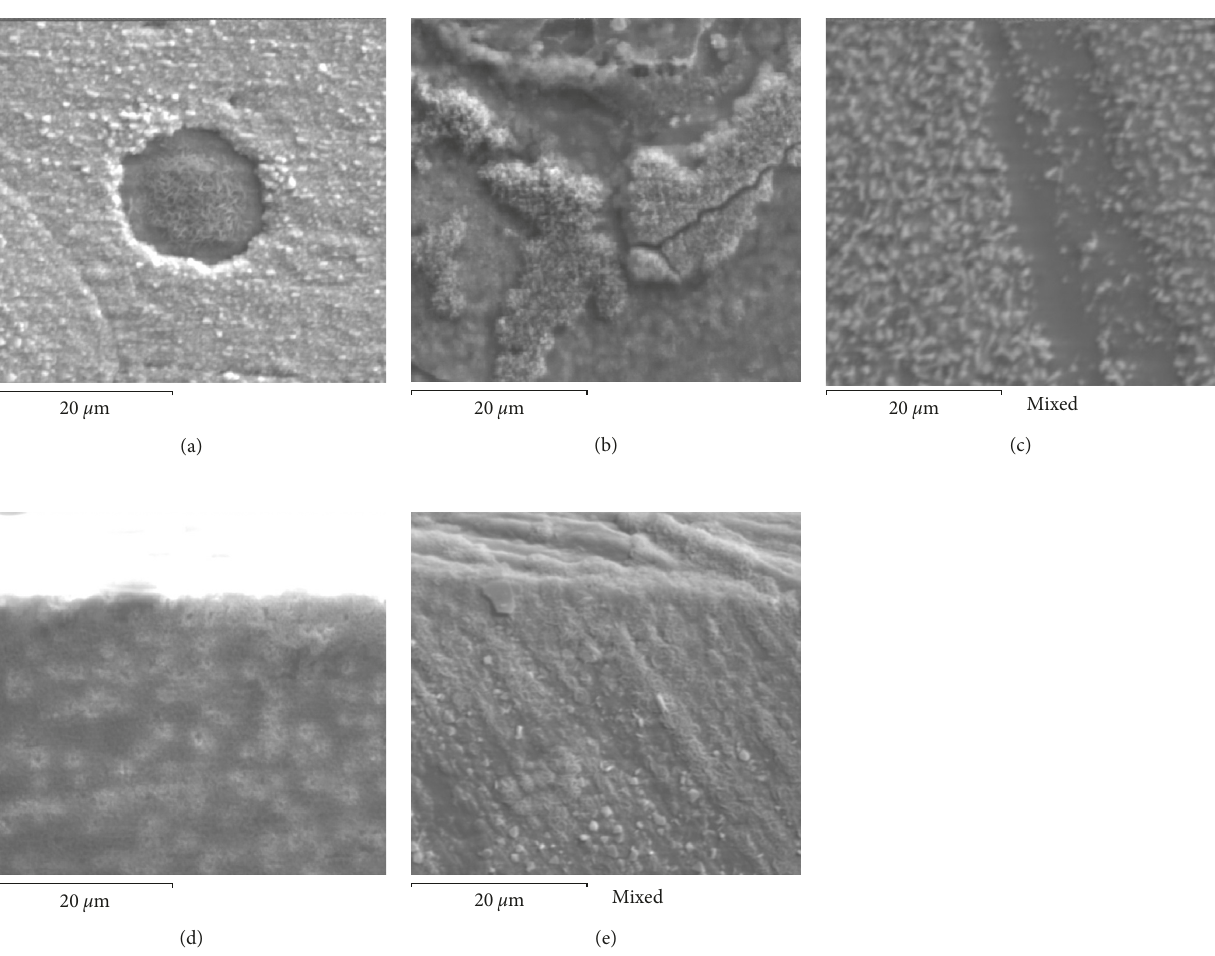
3 Al, (b) Ni 3 Al+1.0% Ag, (c) Ni 3 Al +1.0%